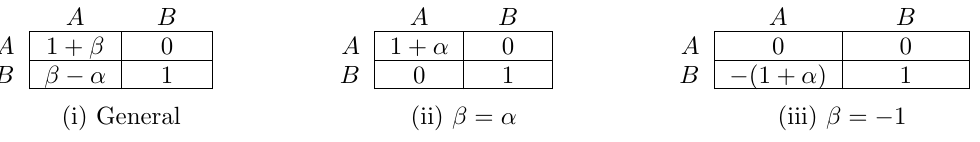
Figure 4. Two player coordination game. For each combination of A and B , entries give payoffs for the row player. Let α > 0 so that ( A , A ) is the risk dominant Nash equilibrium. Panel ( i ): general payoffs up to affine transformation; Panel ( ii ): zero payoff for miscoordination; Panel ( iii ): a stag